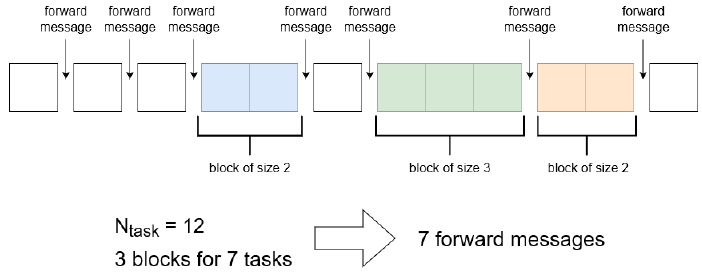
Figure 9. Illustration of the counting of the forward